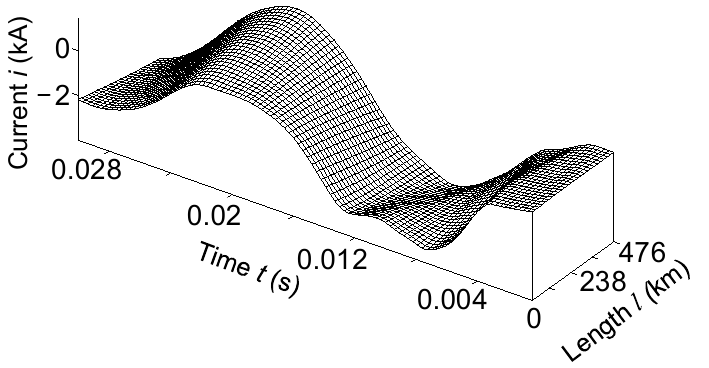
∈ ∈ (0; 0.03) s. (0; 0.03) s. Figure 13. Temporal-spatial current distribution of phase C in line at the time t ∈ (0; 0.03)